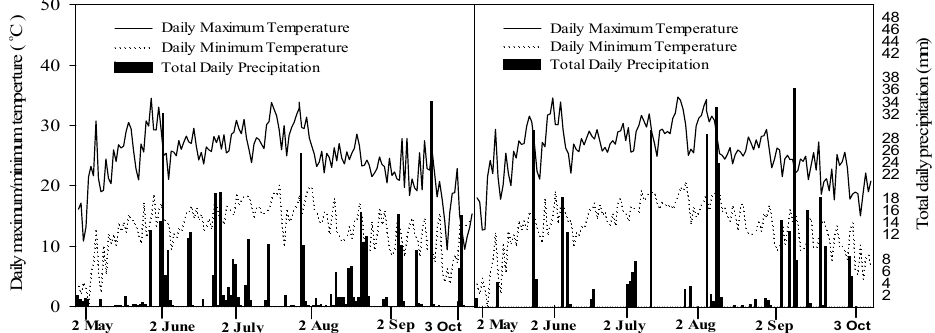
Figure 1. Precipitation and monthly average temperature at the study site during